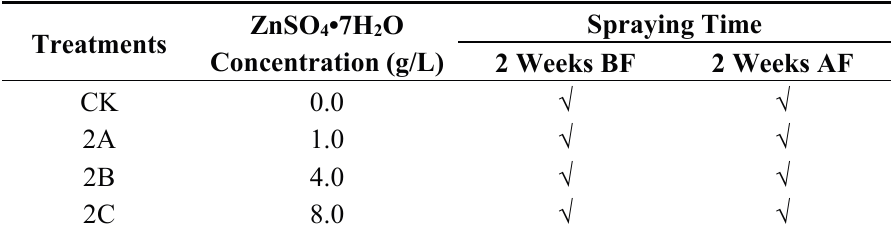
Table 4. Experimental scheme of foliar sprayed